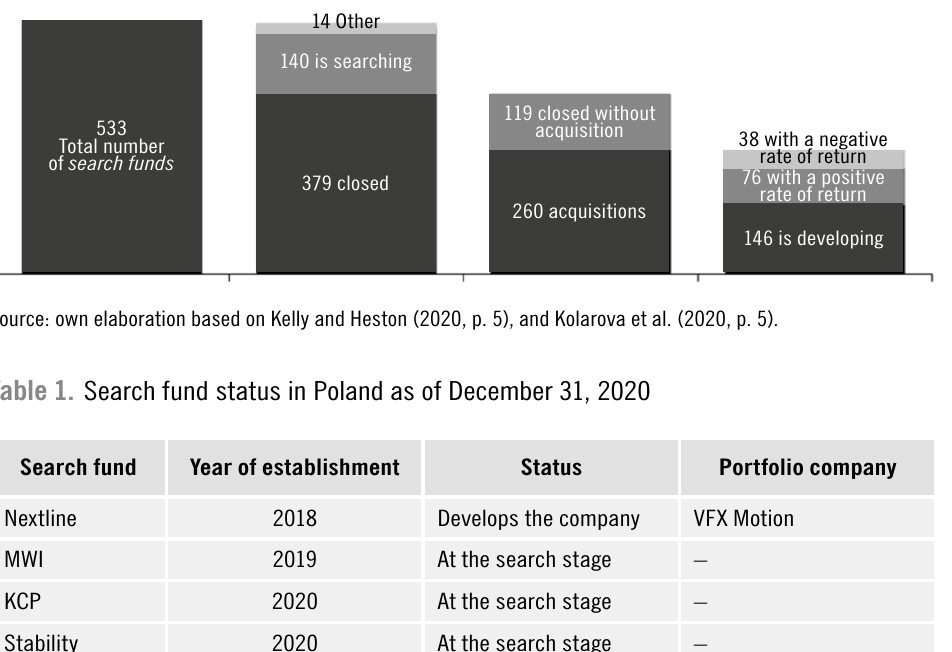
Figure 2. Search fund status globally as of December 31, 2019